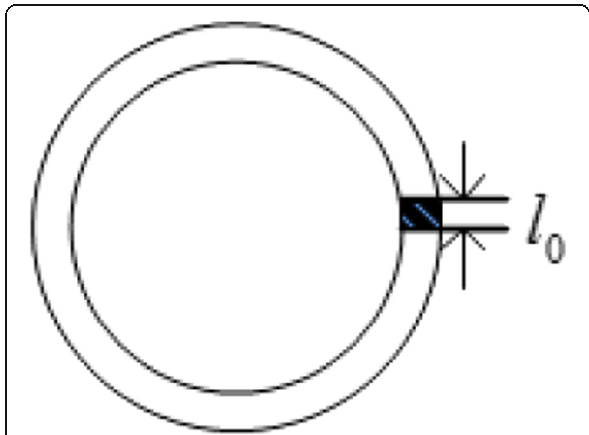
Fig. 8 Air-gapped core schematic diagram